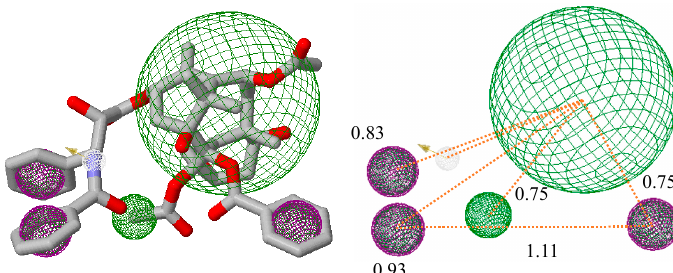
Figure 9. Pharmacophoric model. Green spheres represent a hydrophobic segment, purple spheres an aromatic segment, and the gray sphere a hydrogen donor segment. Distance units = Å.